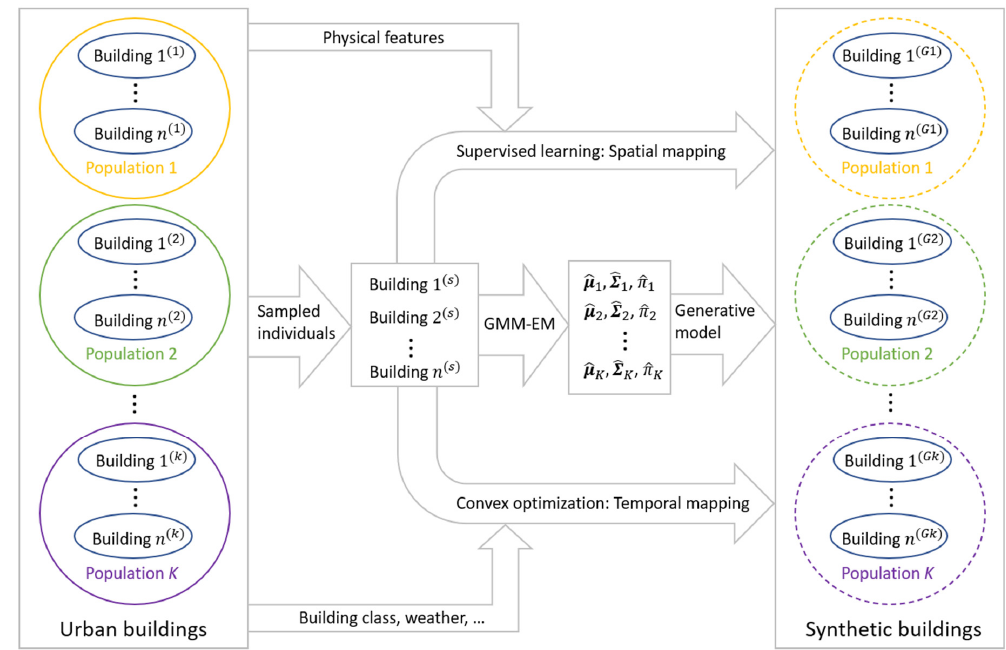
Figure 9. Spatio-temporal mapping of urban buildings from GMM synthetic